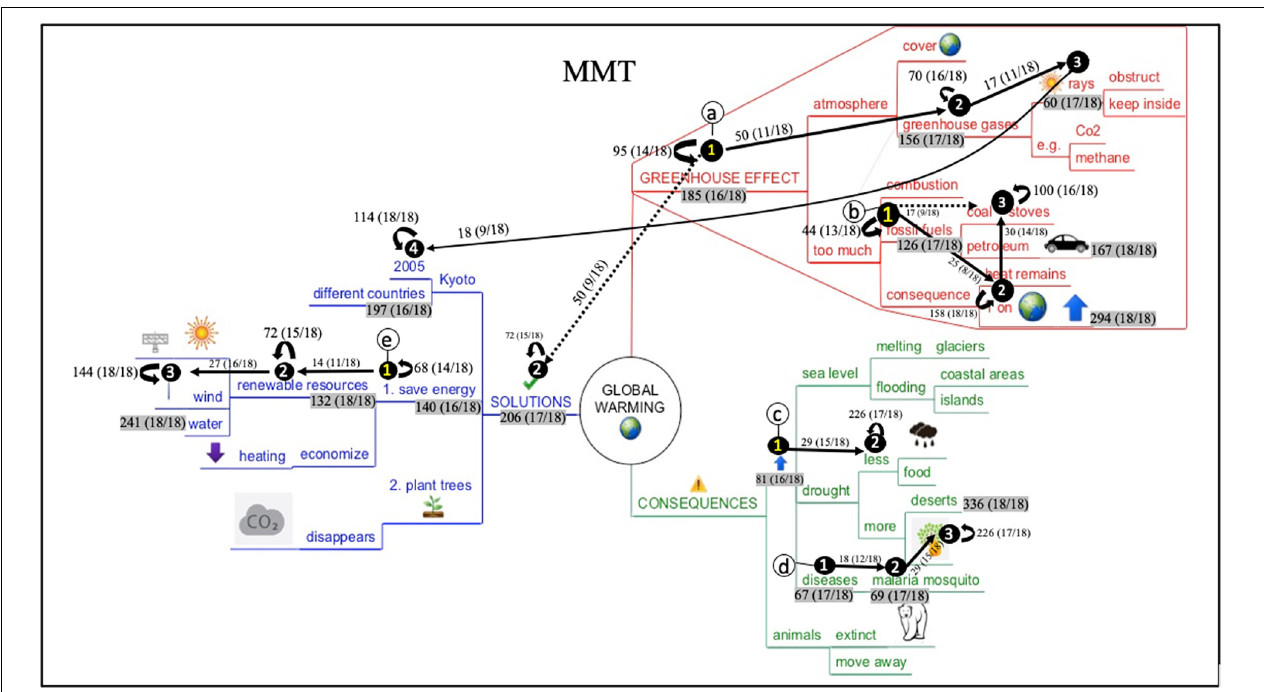
FIGURE 8 | Aggregated process map of the Mind Map-Text (MMT) condition